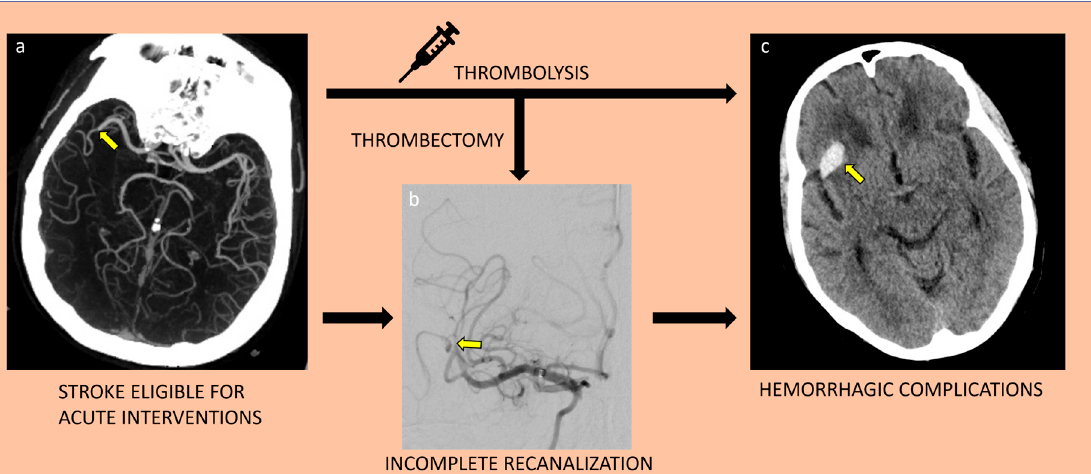
Figure 2. Major challenges of current acute ischemic stroke recanalizing treatments; incomplete recanalization and hemorrhagic complications. Yellow arrow respectively points to the site of vessel occlusion ( a ), incompletely recanalized vessel during intervention ( b ), and hemorrhagic transformation of the initial ischemic infarct territory ( c